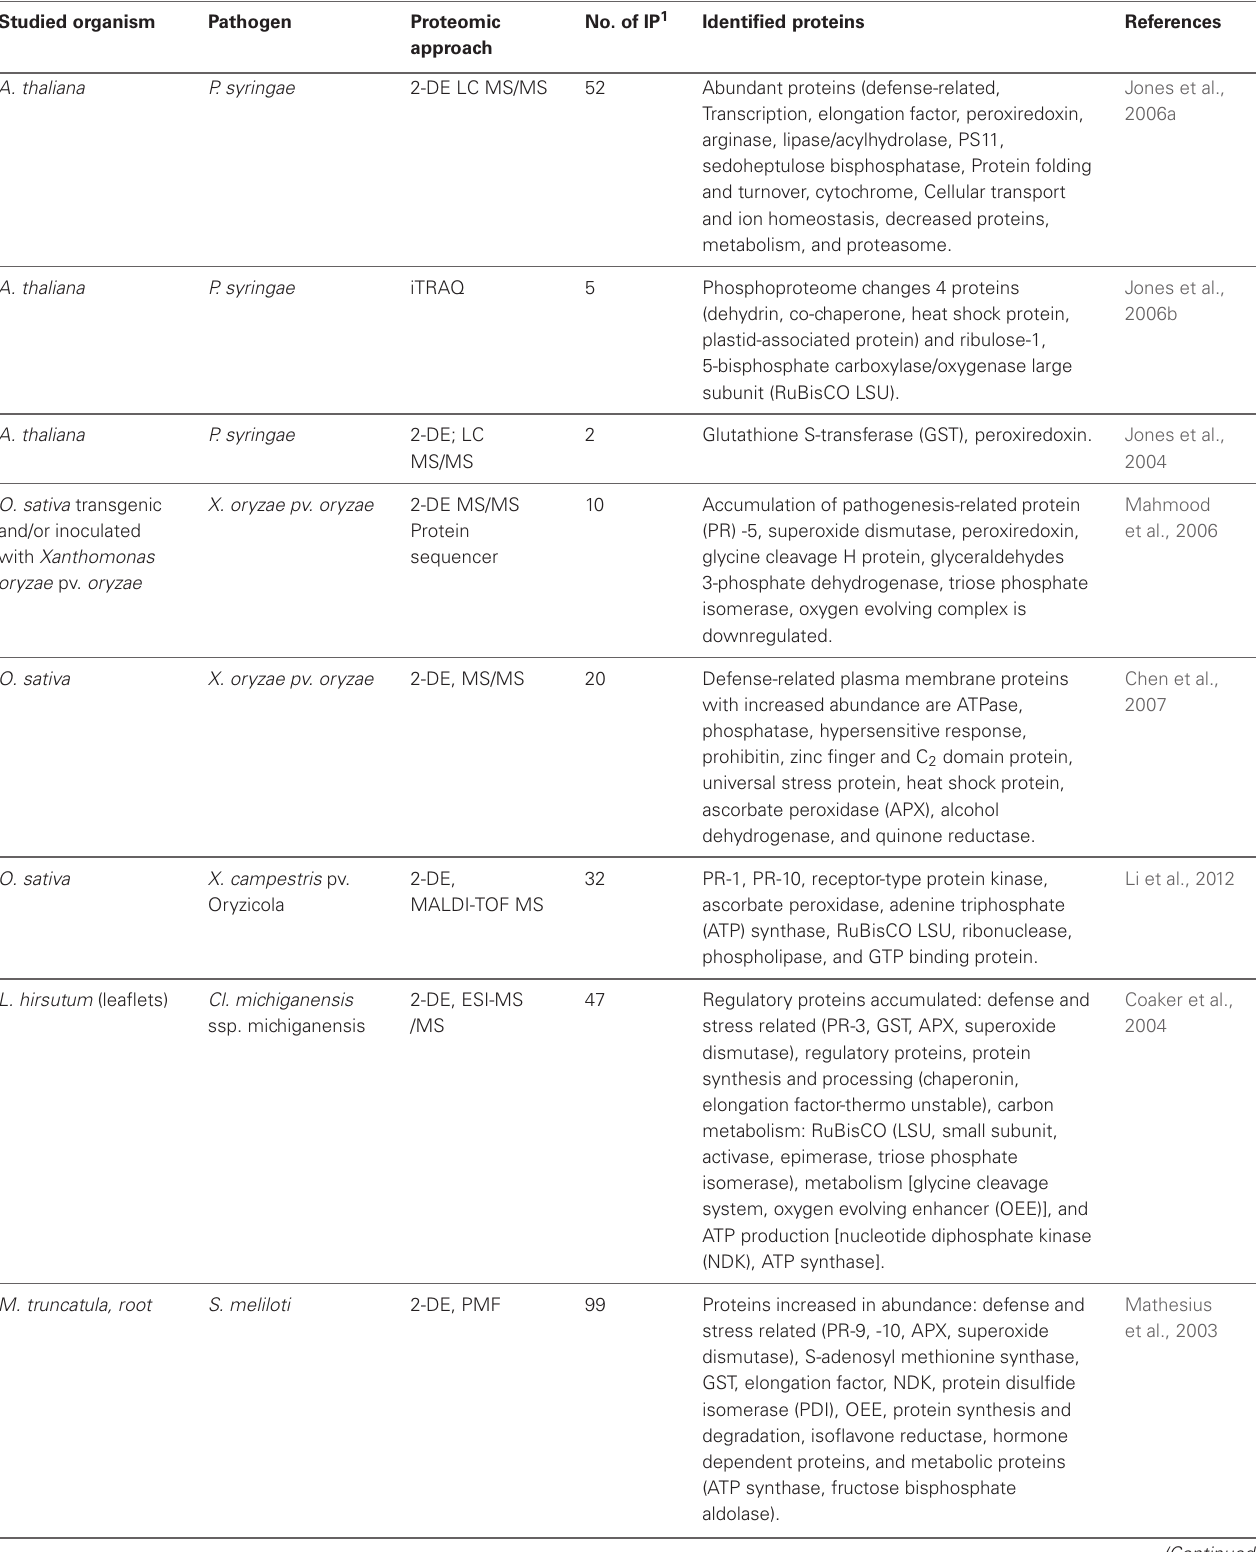
Table 2 | Proteomics analysis of plants in response to pathogenic/symbiotic bacteria. Studied